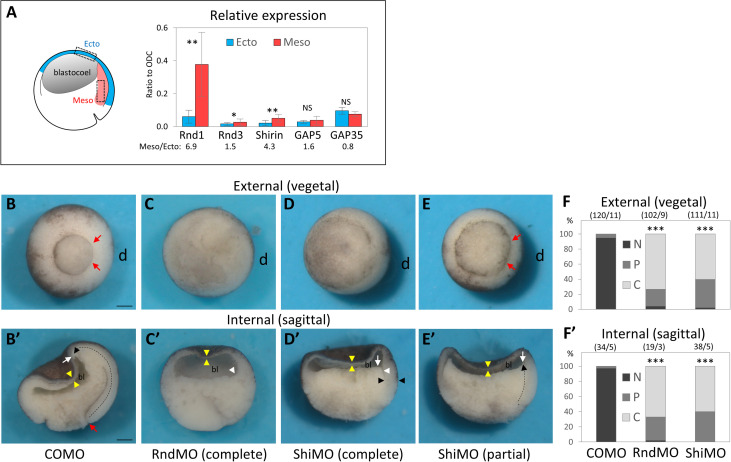
Rnd1 and Shirin are essential for gastrulation.(A) Rnd1 and Shirin expressions are enriched in the mesoderm. RT-qPCR from dissected tissue. mRNA levels in ectoderm and mesoderm, normalized to homogenously expressed ODC. Three to 6 experiments, pairwise 1-sided Student t test. Refer to S1 Data. (B–E) Whole embryo loss-of-function phenotypes: 4-cell stage embryos were injected in the dorsal side (d) with a control (COMO), Rnd1 (RndMO), or Shirin (ShiMO) morpholinos. Embryos were fixed and imaged at stage 11. (B-D) Examples of typical control mesoderm and RndMO and ShiMO phenotypes. (E) Example of a “partial” phenotype (here ShiMO). (B–E) External views from the vegetal pole. Red arrows point to the position of the dorsal blastopore lip of a control embryo, absent in RndMO (C) and ShiMO (D) embryos. (E) In the partial phenotype, the lip is present but the blastopore has remained widely open compared to control. In many embryos, the ventral blastopore is also affected, due to the diffusion of the morpholinos to the ventral blastomeres before complete separation after the 2nd cleavage. (B’–E’) Sagittally bisected embryos. In a control embryo (B’), the extent of involution (dashed black arrow) can be seen by the position of the tip of the mesendoderm (white arrow) that has moved far away from the blastopore lip (red arrow). (C’) RndMO embryo lacking any sign of involution. The white arrowhead points to the dorsal edge of the blastocoel cavity (bl), resembling that of a pregastrula embryo. (D’) Characteristic ShiMO phenotype, with flat blastocoel floor (white arrow) and thicker non-involuted dorsal marginal zone (black arrowheads), both indicative of failed involution. (E’) Partial involution (white arrow). Yellow arrowheads: thin BCR, indicative of ectoderm epiboly in all conditions. Scale bars: 200 μm. (F, F’) Score of the penetrance of the gastrulation external and internal phenotype: N, normal embryo; P, partial inhibition, C, complete inhibition. Comparison by 1-way ANOVA followed by Tukey HSD post hoc test. Refer to S1 Data. ANOVA, analysis of variance; HSD, honestly significant difference; ODC, ornithine decarboxylase; RT-qPCR, reverse-transcription quantitative PCR.